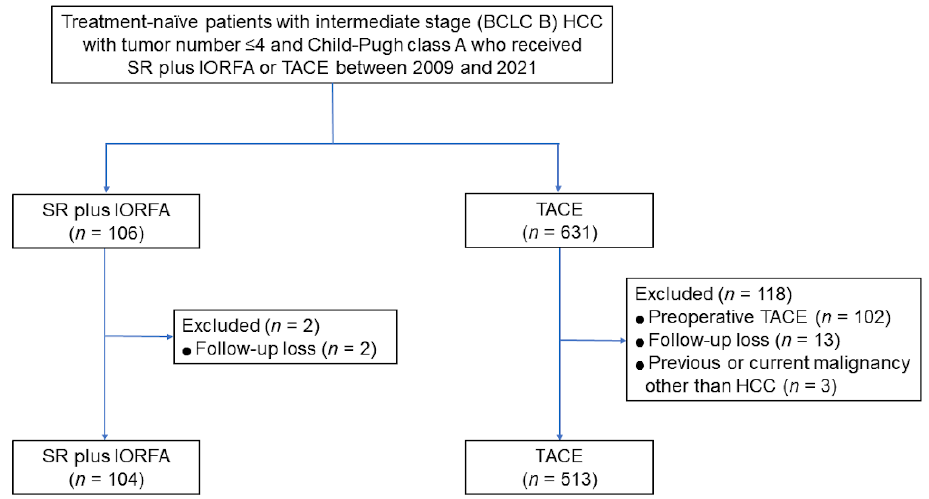
Figure 1. Flow diagram of the study population. Table 1. Demographic and clinical characteristics of patients before and after propensity score matching.